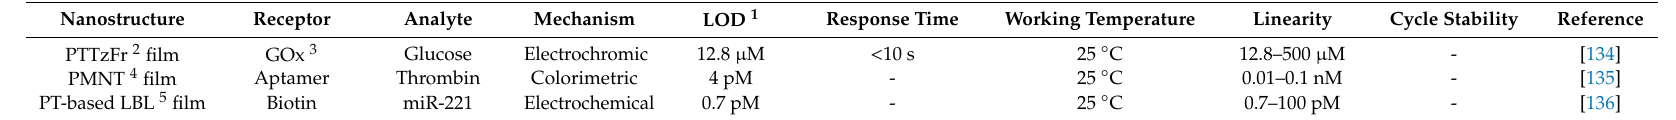
Table 4. Comparative sensing performance and limit of detection of other conducting polymer nanostructure-based